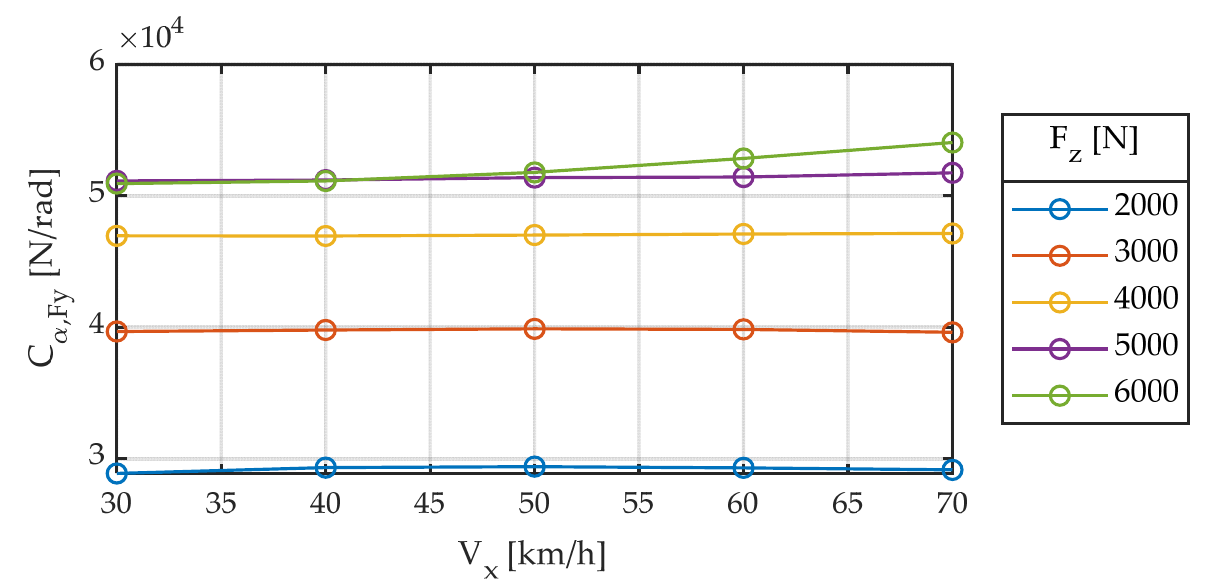
Figure 10. Cornering stiffness for different vertical loads. Slip angle sweep ± 2 ◦ . Frequency 1.0 Hz.